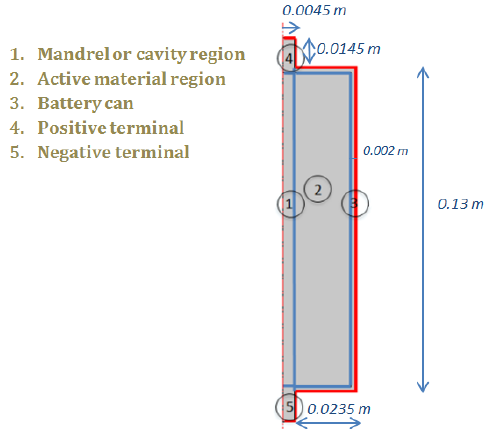
Figure 2. Two-dimensional axisymmetric schematic of the battery.